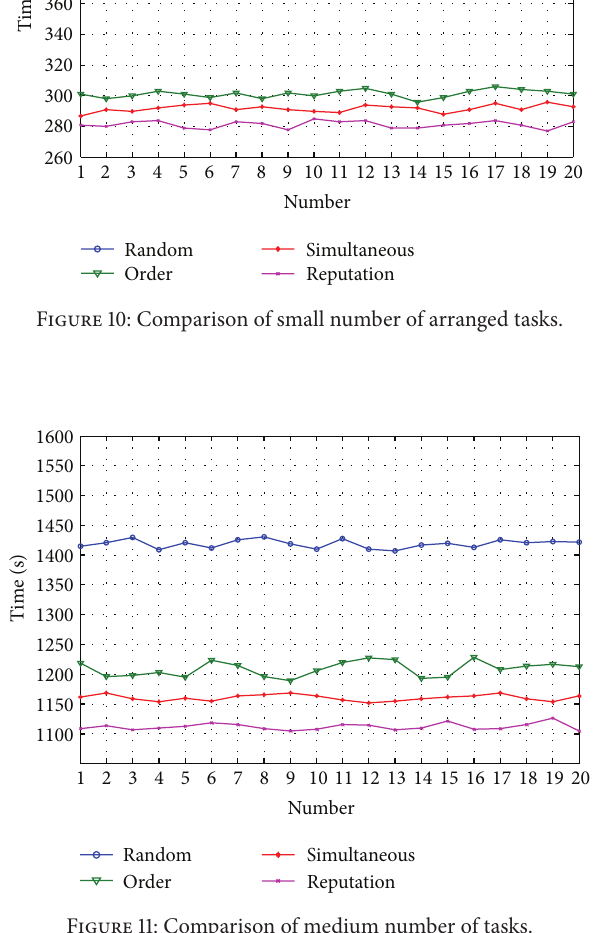
Figure 11: Comparison of medium number of